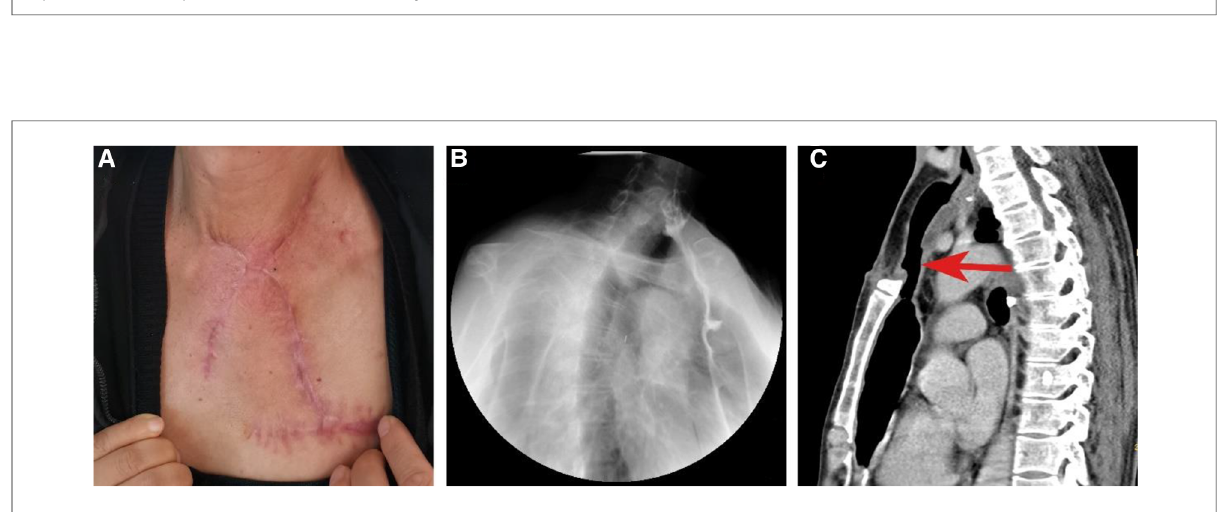
FIGURE 3 Stricture resection and reconstruction of the esophageal defect using a pedicled TAAP fl ap. ( A ) The defects of cervical and thoracic esophagus. ( B ) Design of a pedicled TAAP fl ap. ( C ) The harvesting of a pedicled TAAP fl ap. ( D ) Reconstruction of the defect of cervical and thoracic esophagus using a pedicled TAAP fl ap and thoraco-acromial artery (blue arrow)